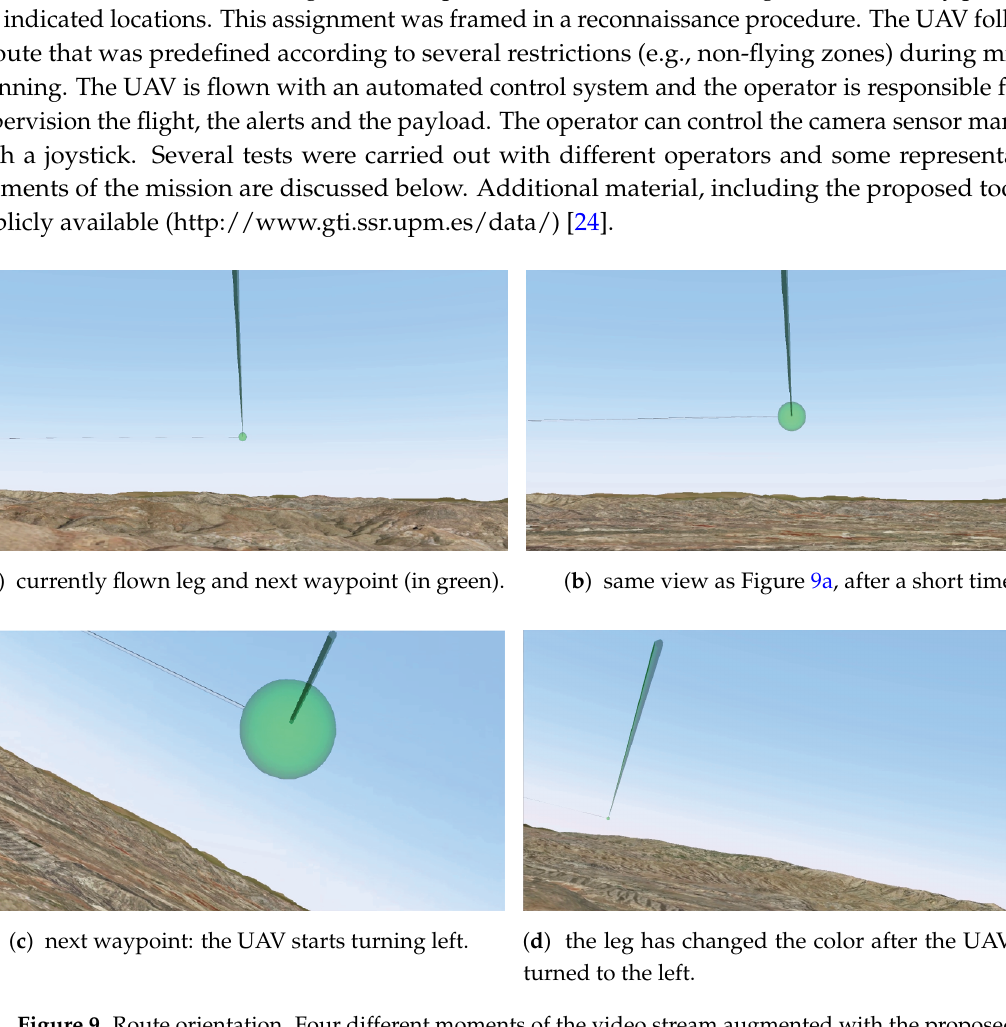
Figure 9. Route orientation. Four different moments of the video stream augmented with the proposed AR tool during a